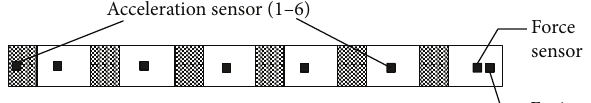
Figure 2: Sensor arrangement of the phononic crystal beam.